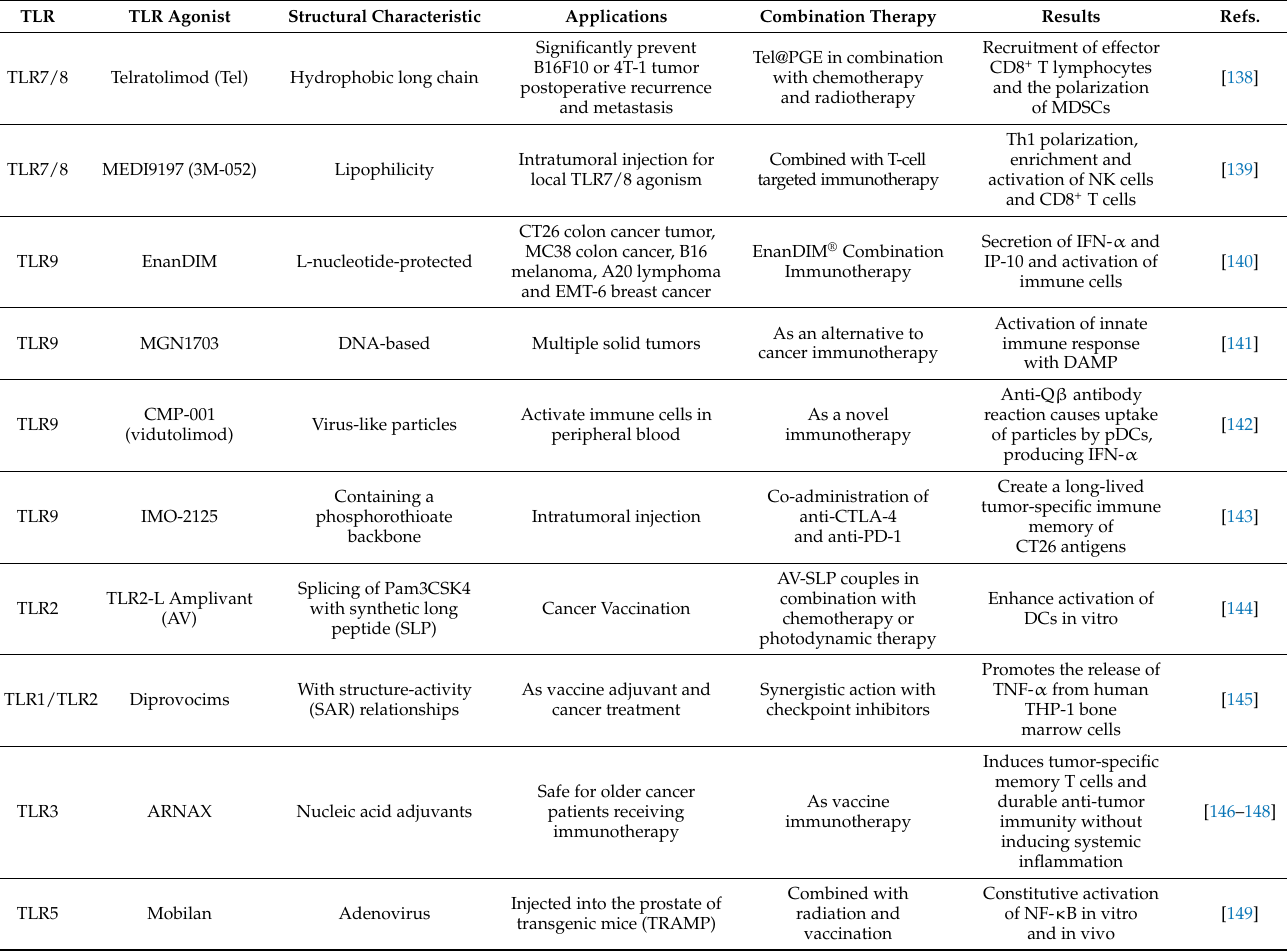
Table 2. Novel TLR agonists in recent